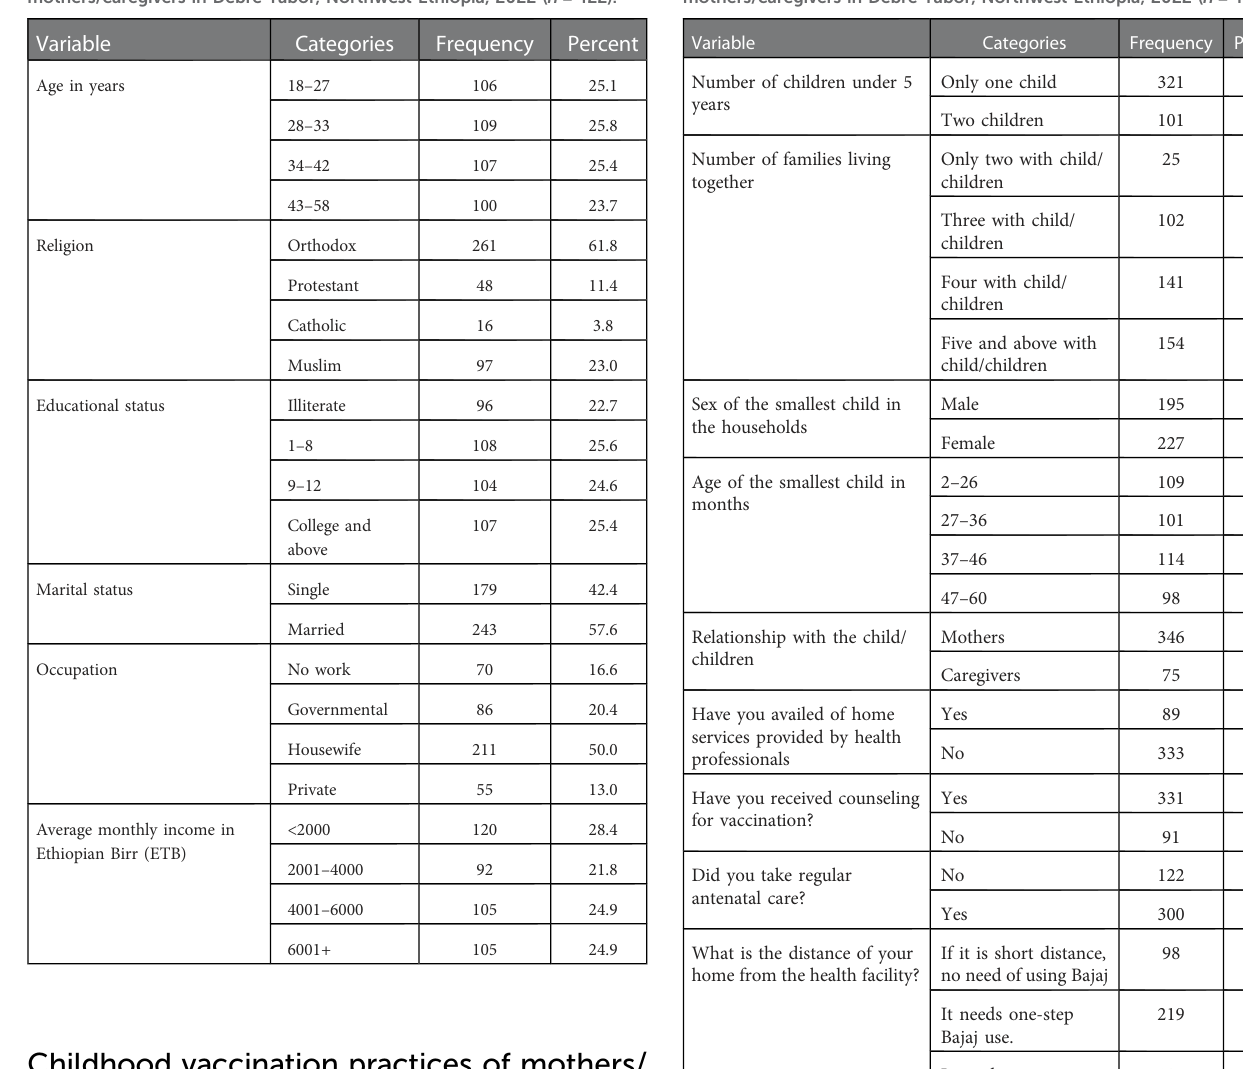
TABLE 2 Vaccination-related information of study participants among mothers/caregivers in Debre Tabor, Northwest Ethiopia, 2022 ( n =422).